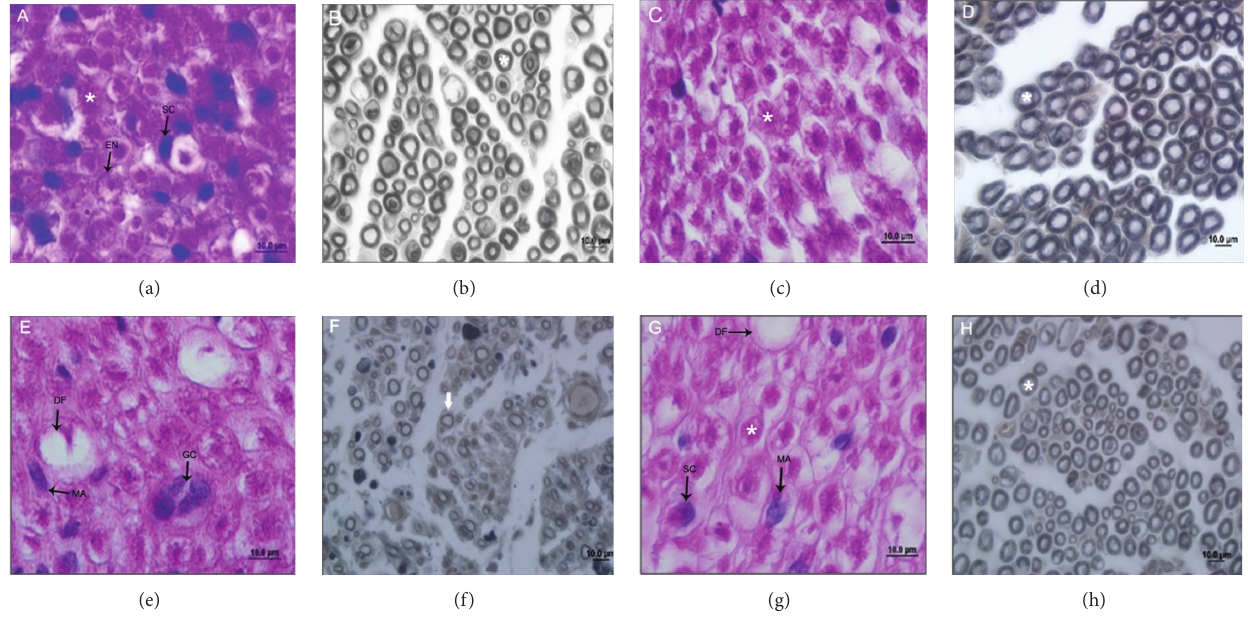
Figure 1: Photomicrographs of the sciatic nerve of Wistar rats in cross section, and the 1st column images are stained with hematoxylin and eosin and the 2nd column with osmium tetroxide. ((a) and (b)) Control group of nerve fibers intact ( ∗ ), surrounded by endoneurium (EN) and the presence of Schwann cell nuclei (SC). In (c) and (d), exercise group, notice the same characteristics of the control group. In (e) and (f), injury group, note the presence of several degenerated nerve fibers (DF), inflammatory infiltration with macrophages (MA), and giant cell clumps (GC), where (f) displayed thin myelin sheath (thick white arrow). In (g) and (h) group injury and exercise, there were degenerated nerve fibers (DF), core Schwann cell (SC), and inflammatory infiltrate (MA) but a large number of fibers with normal appearance ( ∗